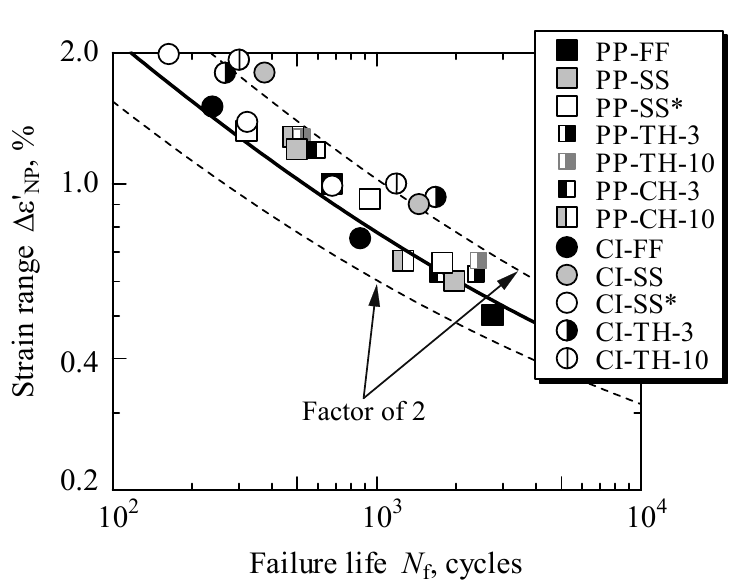
Figure 7: Correlation of N f by modified non-proportional strain range.